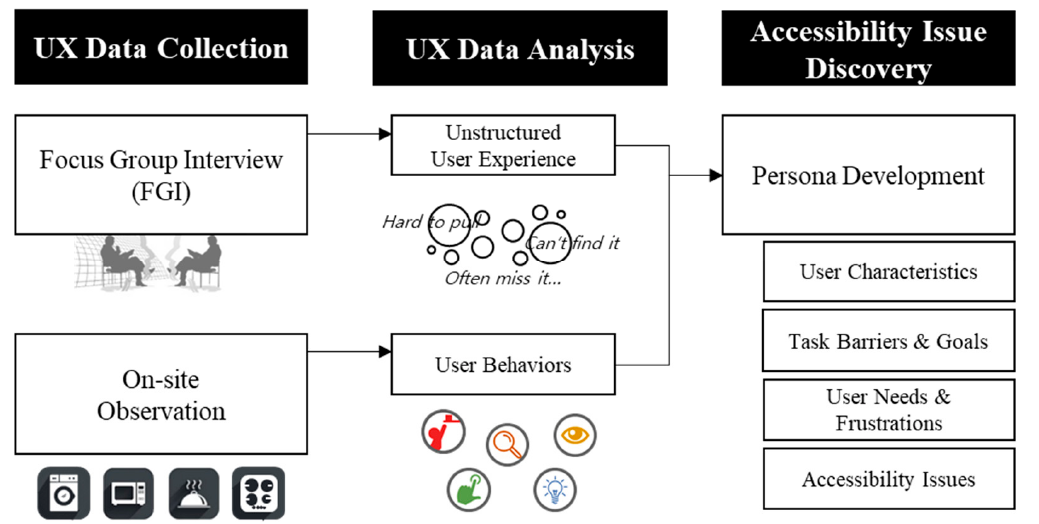
Figure 1. Overview of study procedure to investigate the accessibility issues.